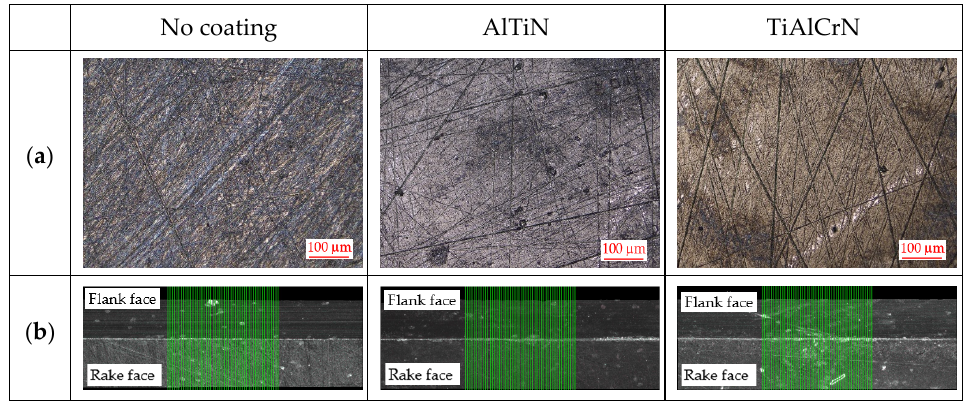
Figure 4. ( a ) Photos of the surfaces; ( b ) cutting edge radius measurements (10× magnified). Table 1. Measured cutting tool geometry